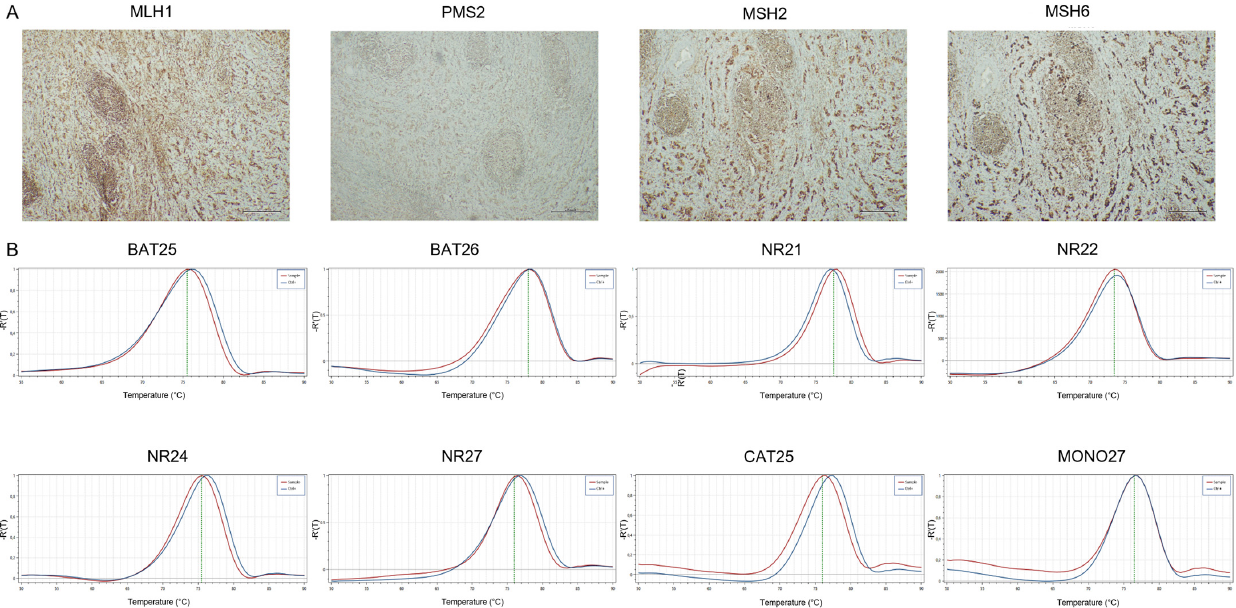
Figure 7. Representative results of GC case showing paMMR-IHC and MSS by PCR. ( A ) MMR-IHC results: intact expression of MLH1, MSH2 and MSH6 in tumor cells (original magnification 10 × ); patchy expression of PMS2 in tumor cells with positive internal control (original magnification 10 × ). ( B ) MSS-PCR results: stability of BAT25, BAT26, NR21, NR22, NR24, NR27, CAT25 and MONO27 (red lines indicate samples while blue lines indicate MSS controls).